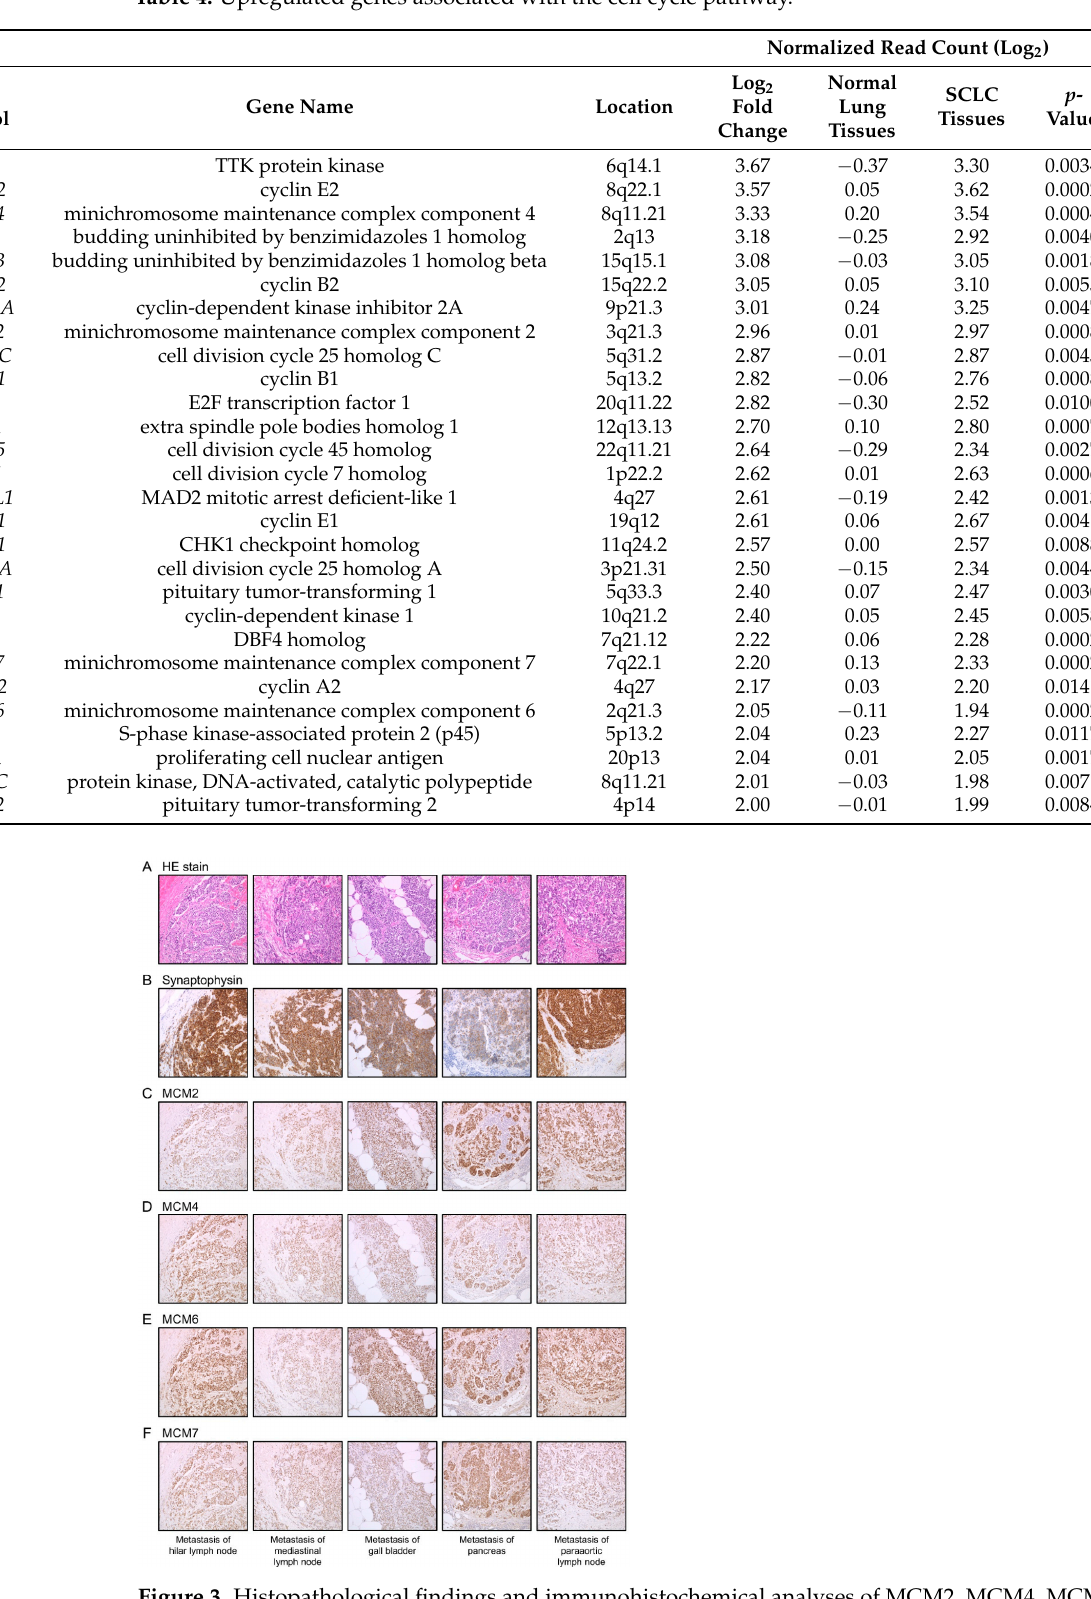
Table 4. Upregulated genes associated with the cell cycle pathway.